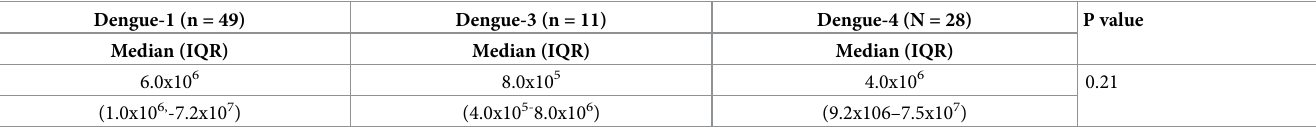
Table 1. Comparison of viremia levels among patients infected with different serotypes of